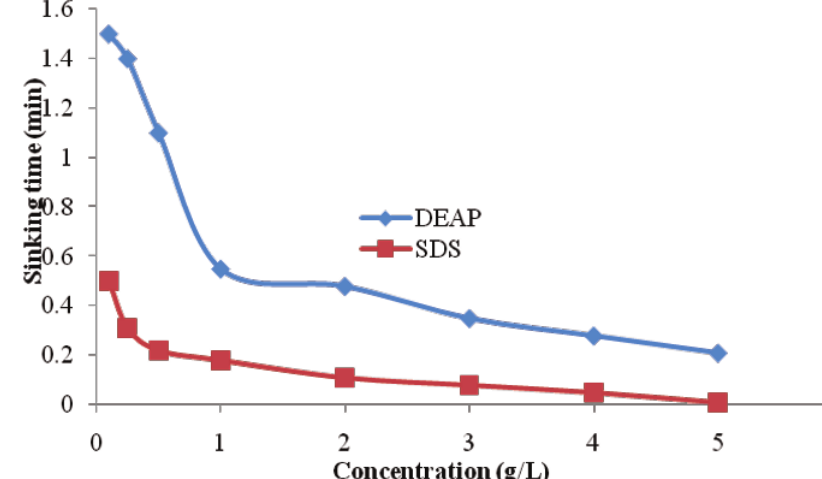
Figure 8. Wetting property as a function of surfactant concentration. DEAP = Sodium phosphate-hydroxy ethanolamide.